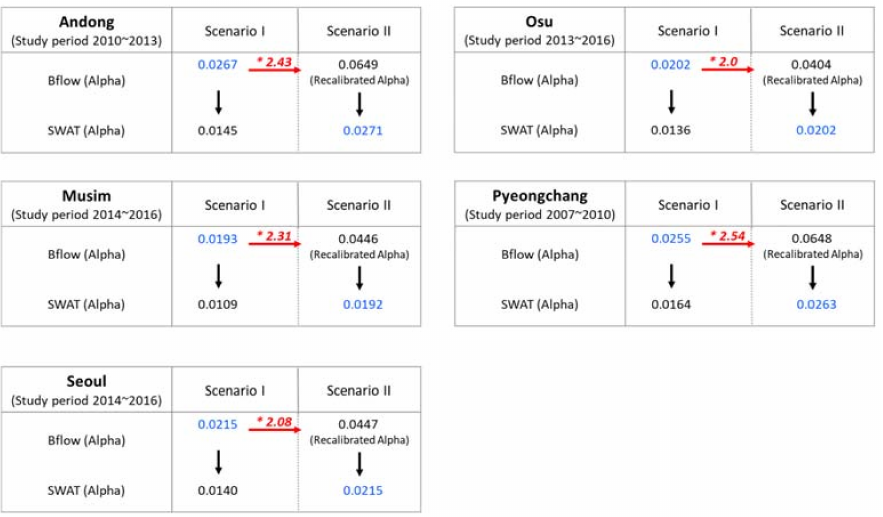
Figure 5. Recalibration of alpha factor for the recession curve for five study watersheds. The values in red represent the differences between the alpha factors calculated from measured and simulated (calibrated) streamflow in Scenario I and the recalibration ratio applied in Scenario II. The blue color in Scenario I is a calculated alpha value by Bflow. The blue in Scenario II is a calculated Alpha value by Bflow after applying the recalibrated alpha to